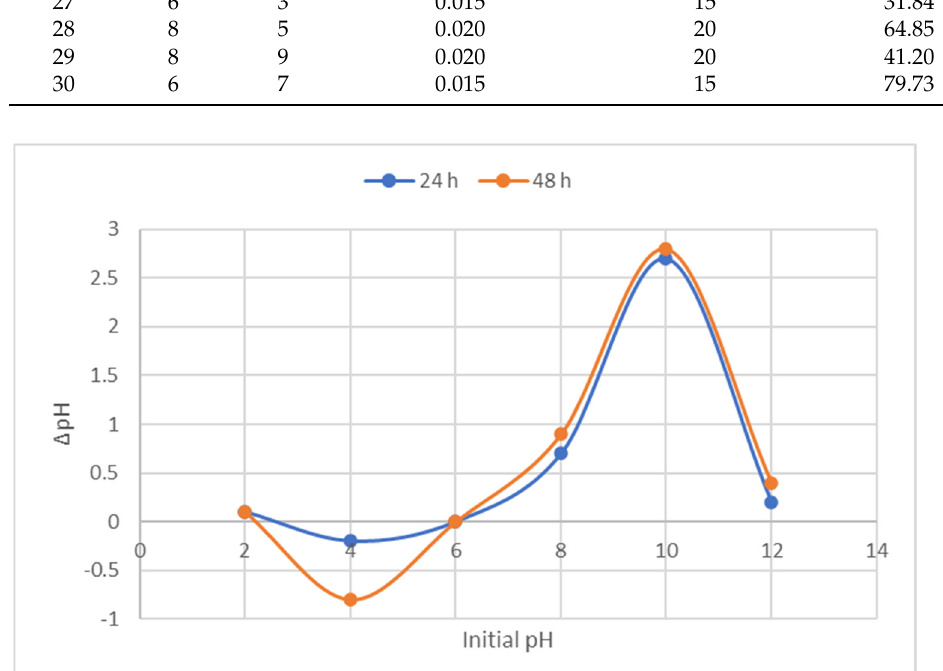
Figure 4. Plot of initial pH versus final pH at 24 h and 48 h.